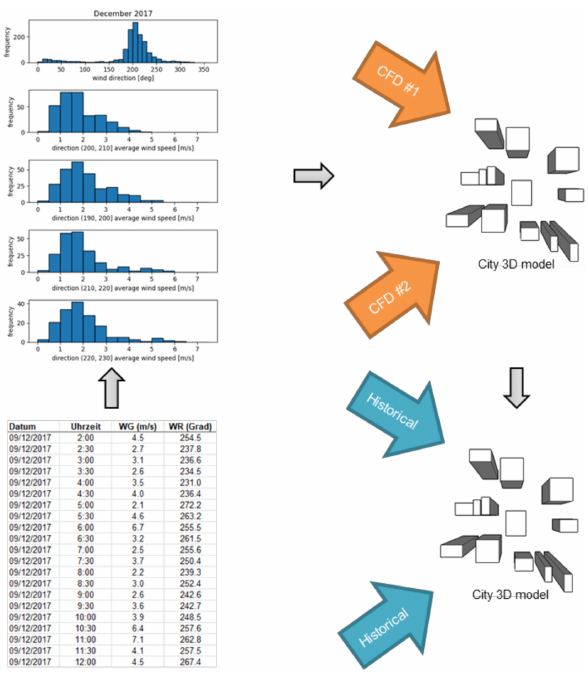
Figure 1. Calculation of boundary conditions for performing static CFD simulations